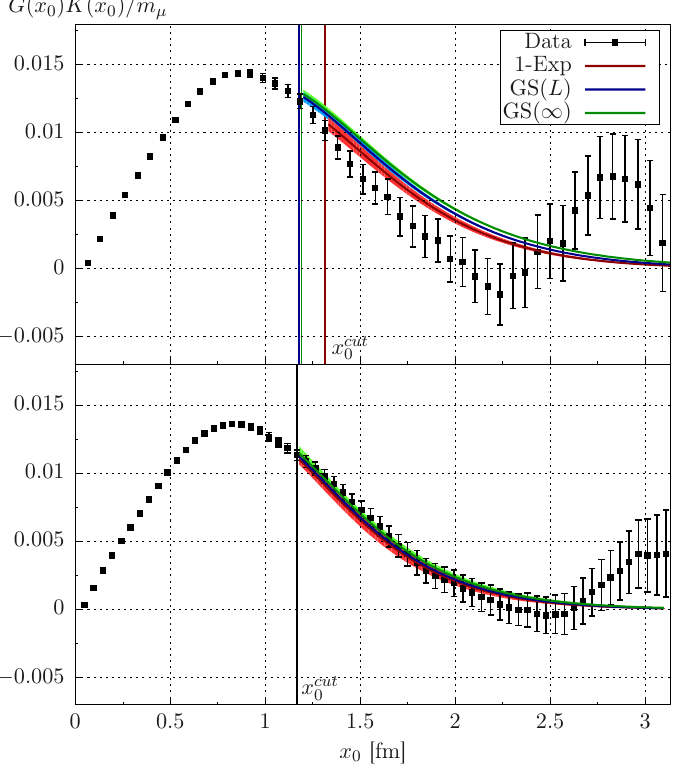
Figure 2 . Data for the light quark contribution to the integrand units of the muon mass for ensembles G8 (top) and O7 (below). The coloured bands, which show the various methods to constrain the long-distance behaviour, start at the respective value of x cut as indicated by the vertical